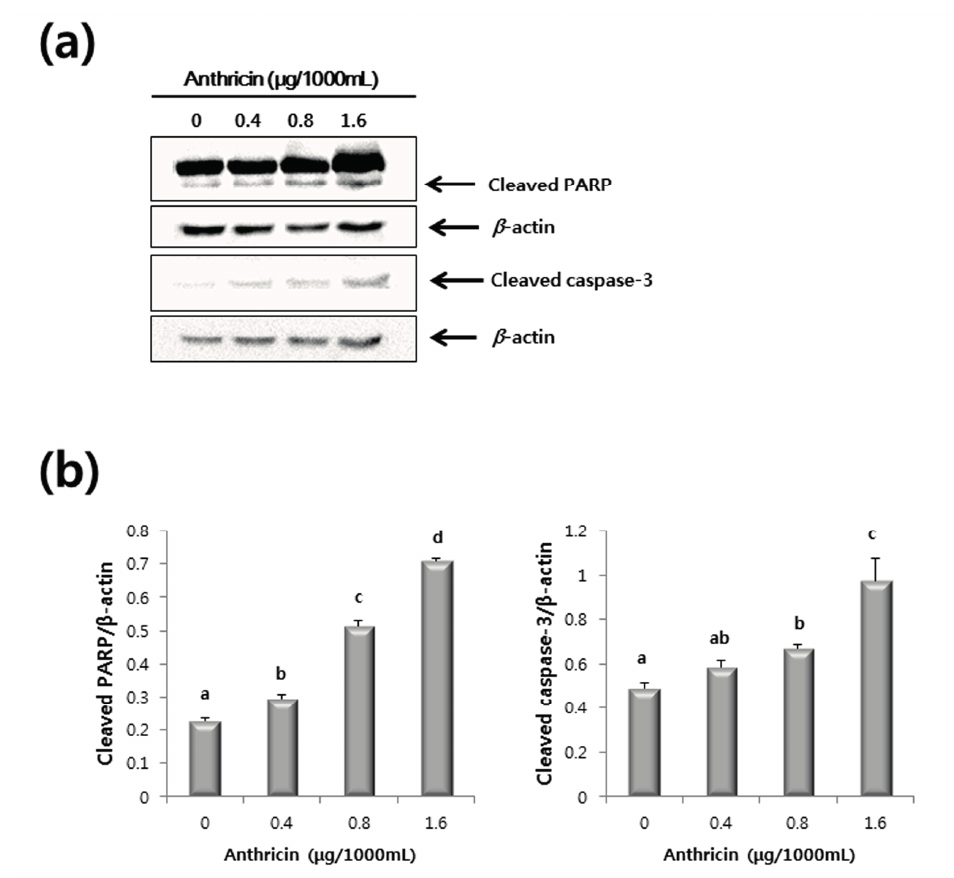
Figure 7. Western blot of HCT116 cells treated with anthricin (0–1.6 μ g/1000mL). ( a ) Representative western blot of caspase-3 and poly ADP ribose polymerase (PARP) protein expression; ( b ) Expression levels of caspase-3 and PARP protein. The level of each protein was normalized to beta-actin protein levels. The letter labels on the graph indicate statistically significant differences between samples ( p < 0.05) based on one-way ANOVA with Tukey’s post hoc